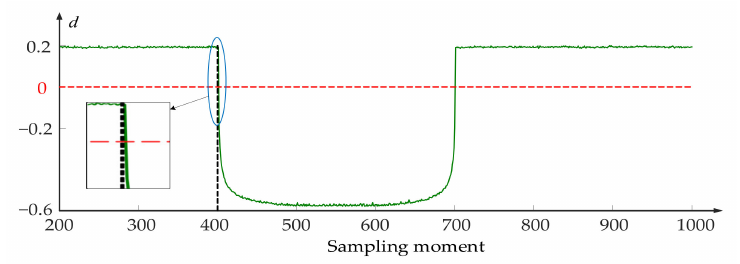
Figure 9. Change curve of d .